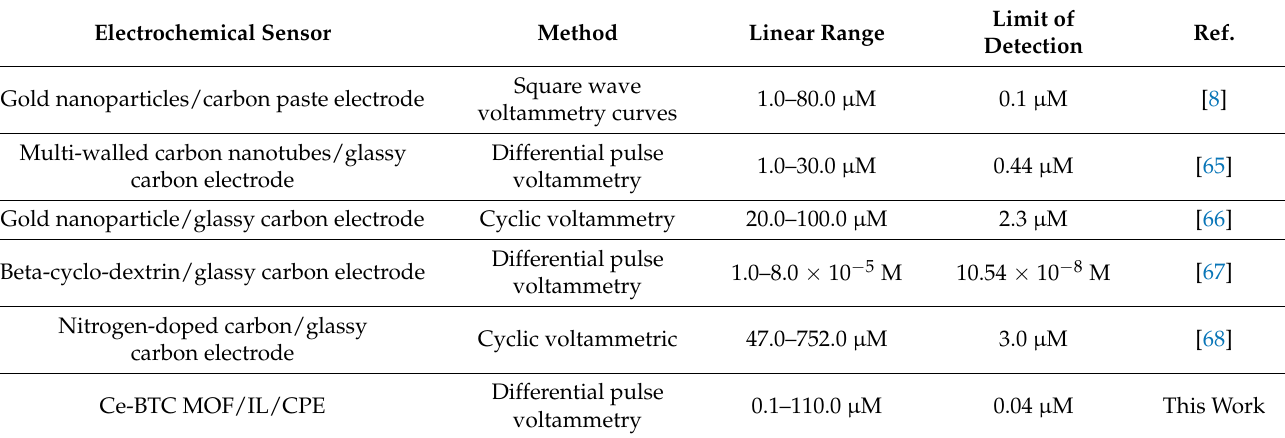
Table 1. Comparing the electroanalytical performance of the Ce-BTC MOF/IL/CPE with other electrochemical sensors for KTC determination.